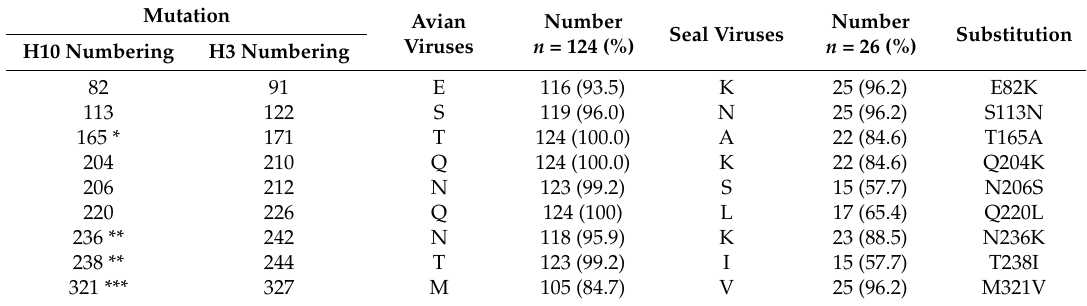
Table 1. Prevalence of fixed mutations in seal viruses compared to other European H10Nx viruses. Mutation Avian